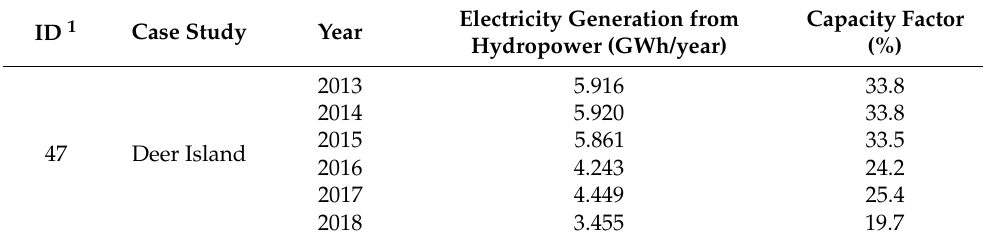
Table 5. Annual fluctuations in electricity generation and capacity factor for one case study. ID